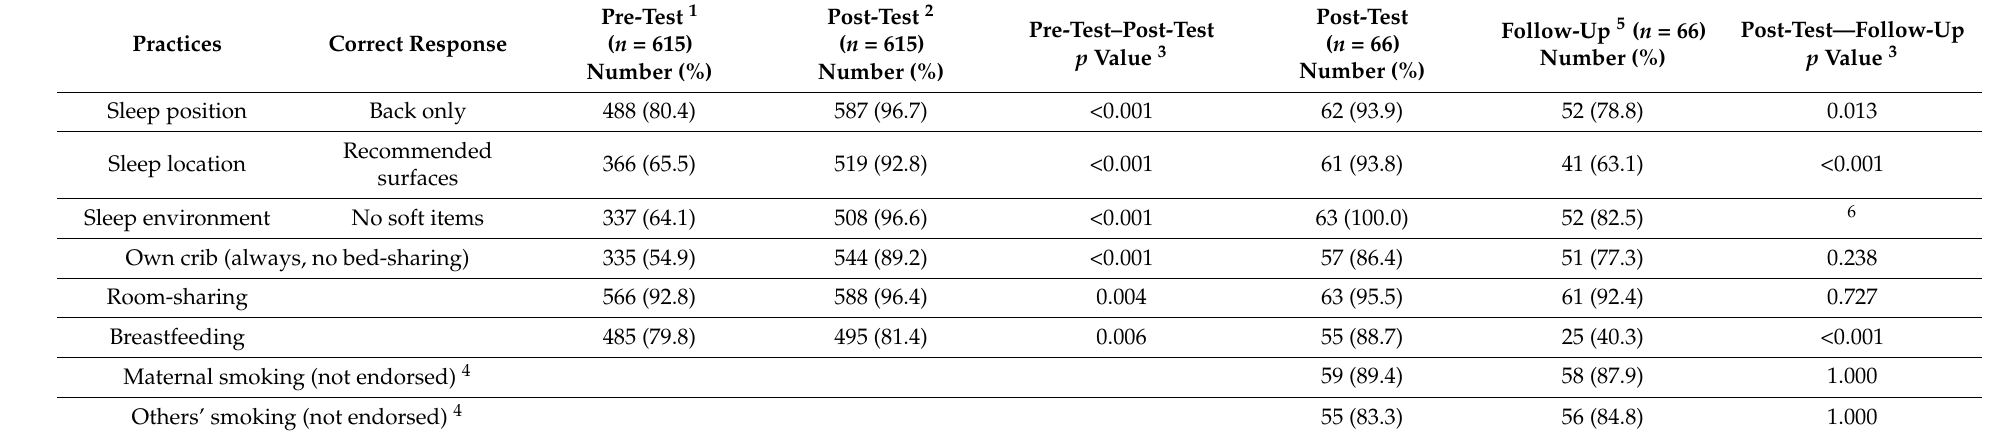
Table 3. Intended and actual practices—comparison of correct responses on matched